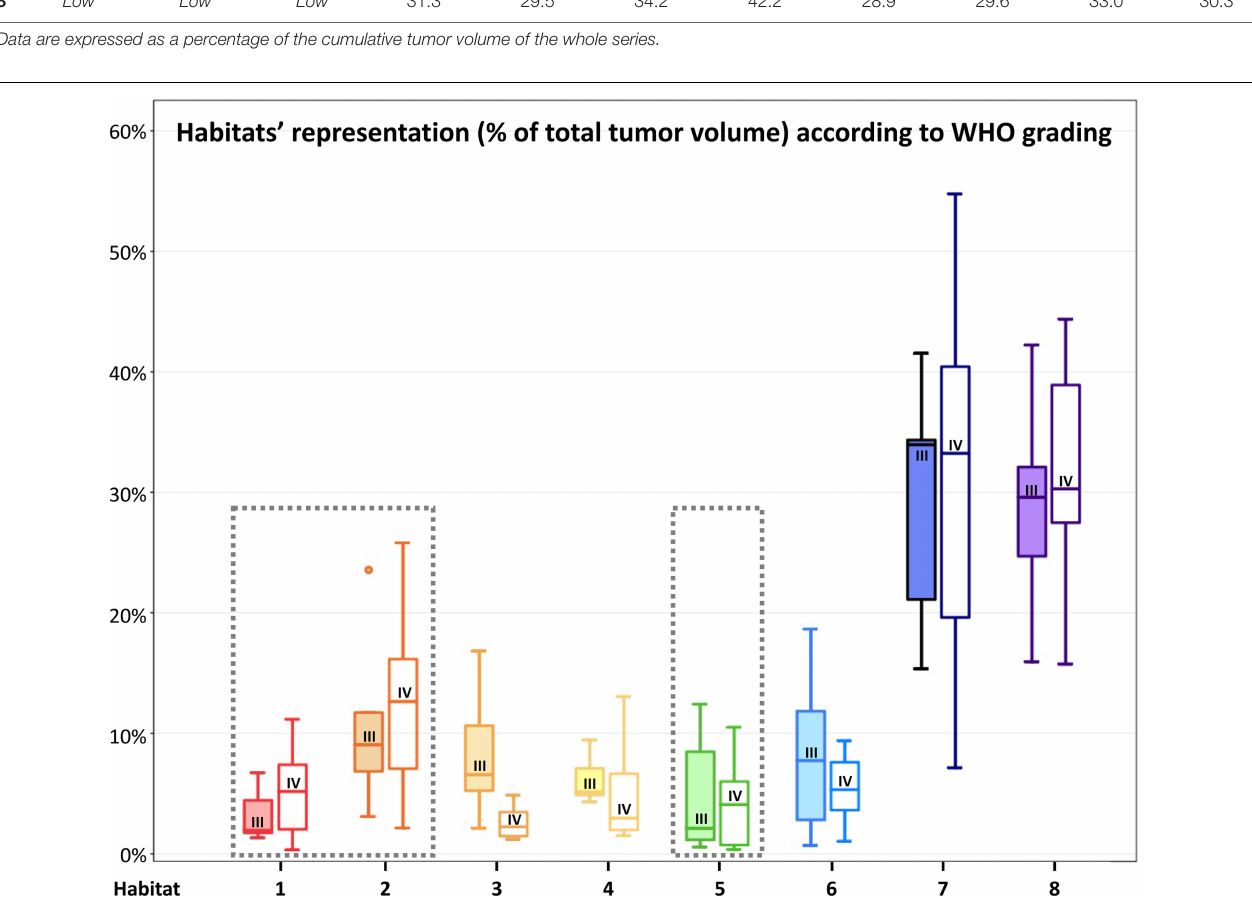
FIGURE 7 | Habitats’ representation (% of total tumor volume) according to WHO 2016 grade. For each habitat, the boxplot on the left (with filled color) represents WHO grade III tumors, while the boxplot on the right (not filled with color) represents WHO grade IV tumors. WHO grade IV gliomas had a higher (although not statistically significant) representation of Habitat 1 and 2 (considered the most aggressive clusters from a metabolic point of view) and Habitat 5 (mostly associated with necrotic areas). The most aggressive clusters are surrounded by a gray box with a dashed